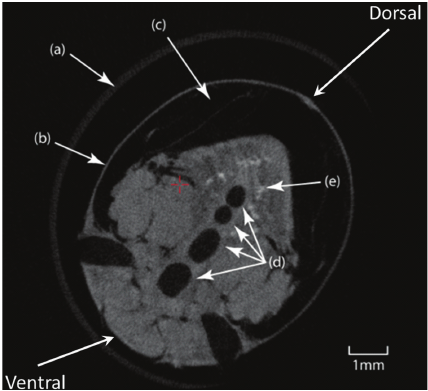
Figure 6: A 2D micro-CT image showing a transverse section through a C. septempunctata abdomen with details of (a) wall of plastic tube-mount, (b) elytra, (c) air space containing folded wings between elytra and dorsal tergites, (d) air sacs, and (e) malpighian tubules.